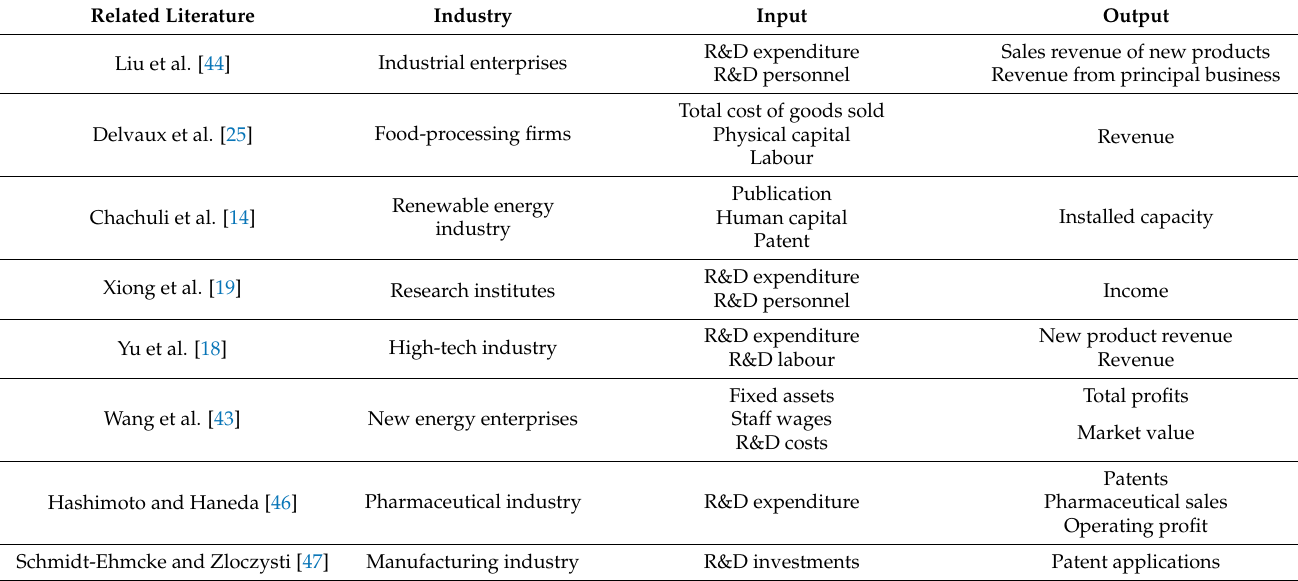
Table 3. Indicator selection for R&D performance evaluation.